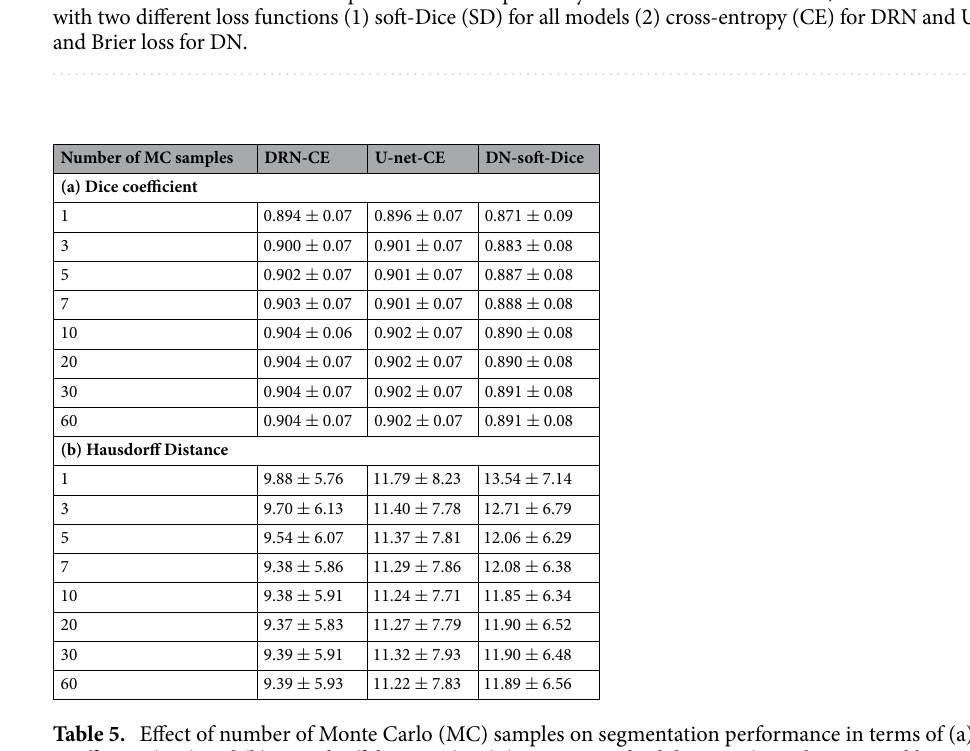
using T ∈ { 1, 3, 5, 7, 10, 20, 30, 60 } samples. Results of these experiments are listed in Table 5. We observe that segmentation performance started to converge using seven samples only. Performance improvements using an increased number of MC samples were largest for the Dilated Network. Overall, using more than ten samples did not increase segmentation performance. Hence, in the presented work T was set to 10. Effect of patch-size on detection performance. The combined segmentation and detection approach detects segmentation failures on region level. To investigate the effect of patch-size on detection performance three different patch-sizes were evaluated: 4 × 4, 8 × 8, and 16 × 16 voxels. The results are shown in Fig. 7. We